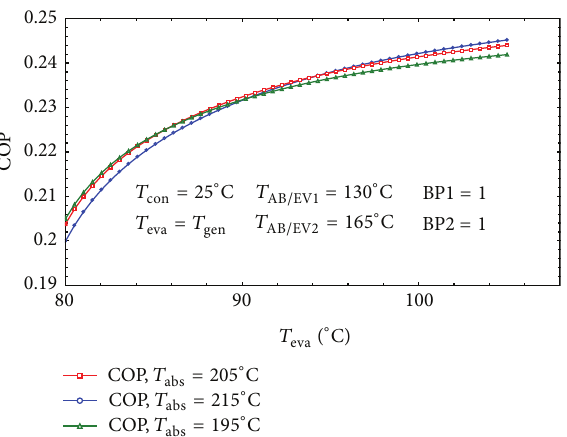
Figure8:Theeffectof 𝑇 𝑇 . abs